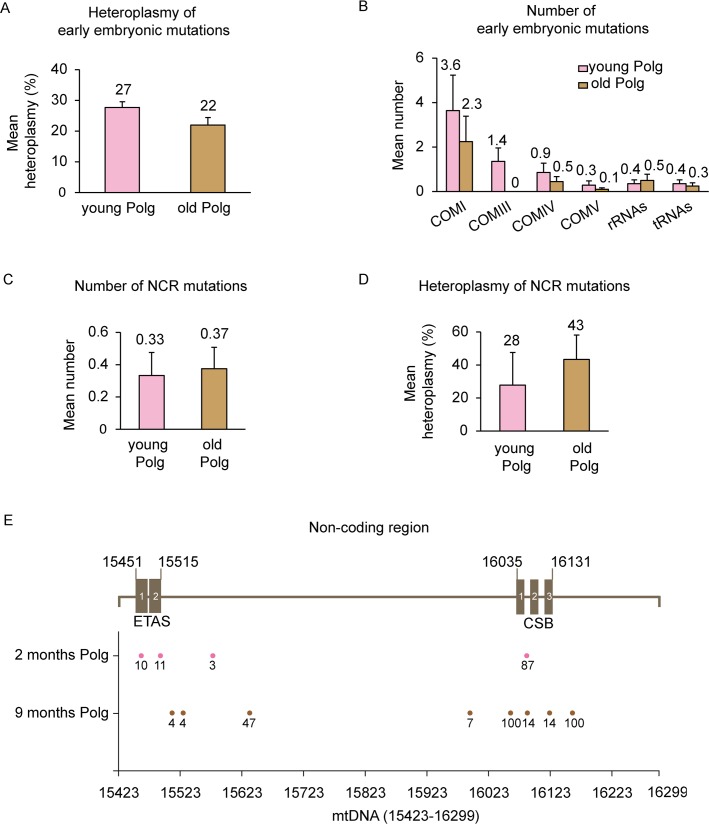
Early embryonic and NCR mtDNA mutations in Polg mice.(A) Bar graphs representing changes in mean heteroplasmy of early embryonic mutations with Polg mice aging. Error Bars, mean ± SEM. (B) Distribution of non-synonymous early embryonic mtDNA mutations among different genes. Error bars, mean ± SEM. (C) Quantification of mtDNA mutations in the non-coding region (NCR) in Polg mice (n = 12 for 2 months; n = 24 for 9 months). Error bars, mean ± SEM. (D) Bar graphs representing mean heteroplasmy levels of NCR mtDNA mutations in Polg mice with aging. Error bars, mean ± SEM. (E) Summary of mtDNA mutations found in the NCR region (mtDNA15423-16299) in Polg mice. Dots represent mtDNA mutations and numbers under dots represent the heteroplasmy levels. ETAS indicates the extended termination associated sequence and CSB indicates the conserved sequence block.